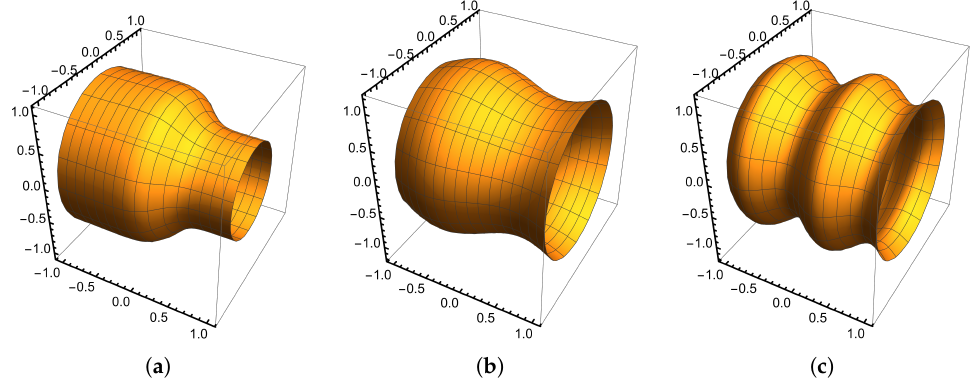
Figure 2. Three examples of shells of revolution with non-uniform type of curvature. ( a ) Modelname − 1 PEHP: f ( x ) = 4 tanh ( 5 x − 1 ) . ( b ) Modelname EH: f ( x ) = 1 − 1 5 5 f ( x ) = 1 + 1 sin ( 2 π x ) 8